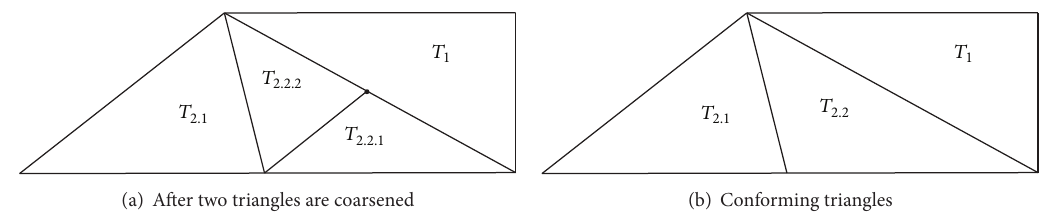
Figure 2: Illustration of the coarsening